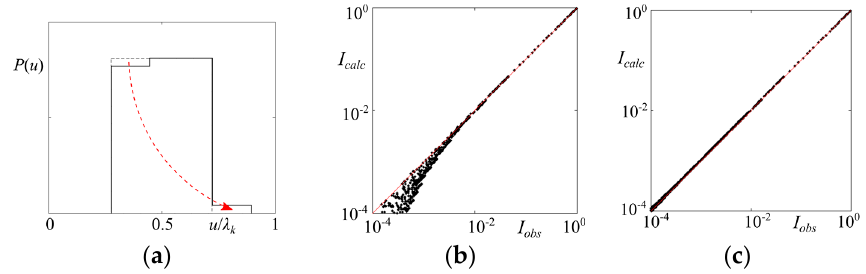
Figure 9. ( a ) AUC for the Fibonacci chain with phasons (flip ratio α = 5%). Red arrow show the move of the fragment originally placed within the AUC of ideal Fibonacci chain to a new position where there was zero-probability before; ( b ) Calculated vs. “observed” intensities in the diffraction diagram of Fibonacci chain with phasons ( α = 5%) and standard phasonic Debye-Waller correction given by formula (18). The characteristic bias is observed for weak reflections ( I < 10 − 2 ); ( c ) The same figure as (b) but with correction given by formula (17) obtained by a statistical method. Perfect fit is observed with only small spread caused by numerical errors (finite size of sample, number of atoms of about 10 6